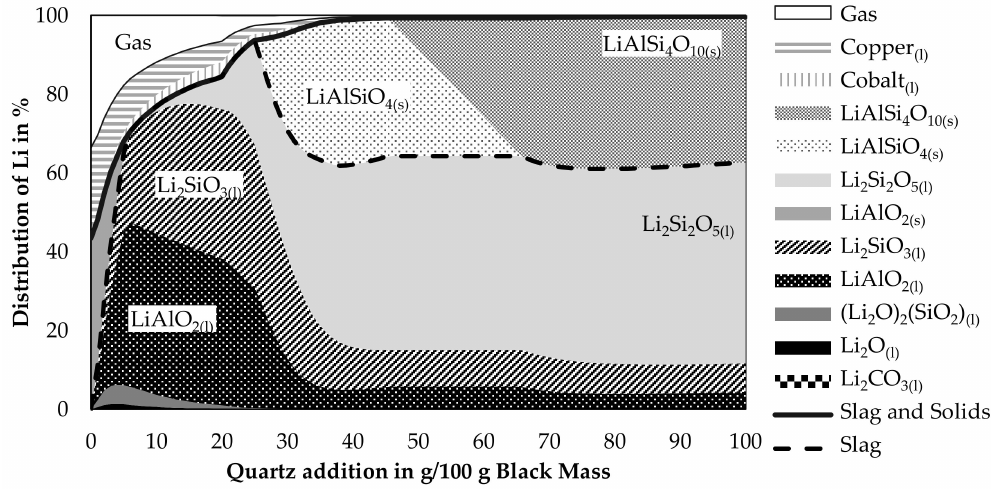
Figure 7. Distribution of lithium into di ff erent phases occurring in the process at 1600 ◦ C with a CuO-addition of 65 g per 100 g black